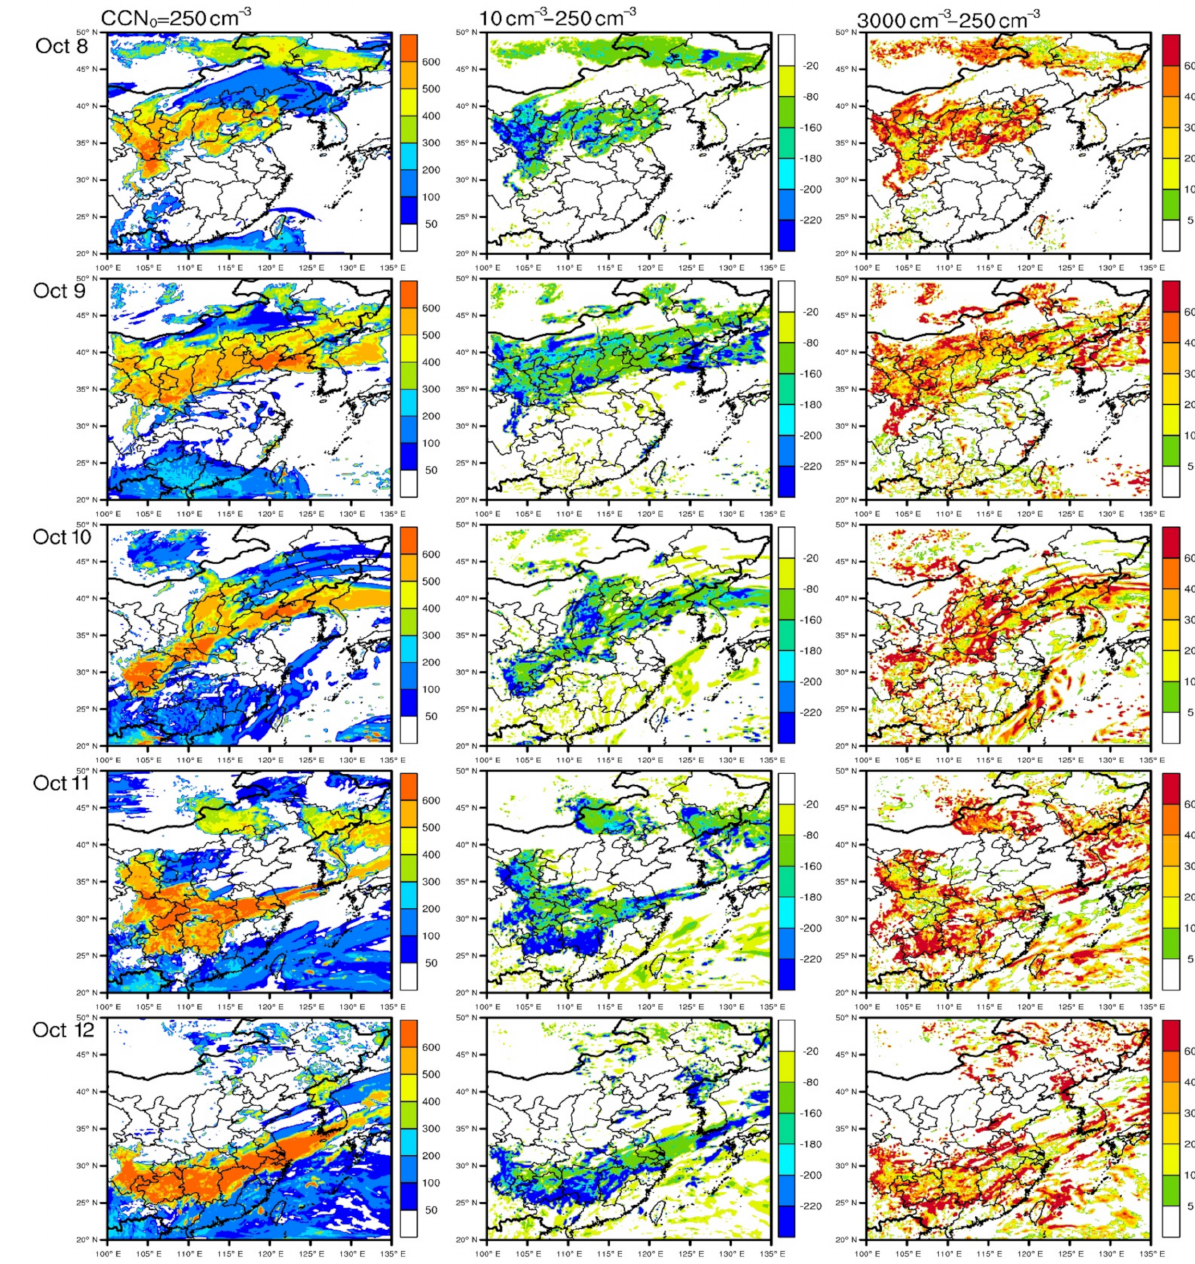
Figure 8. Daily CDSRF (W/m 2 ) at 12:00 UTC from 8 to 12 October 2017 ( left : CCN 0 = 250 cm − 3 , mid : difference between CCN 0 = 10 cm − 3 and CCN 0 = 250 cm − 3 , right : difference in values between CCN 0 = 3000 cm − 3 and CCN 0 = 250 cm − 3